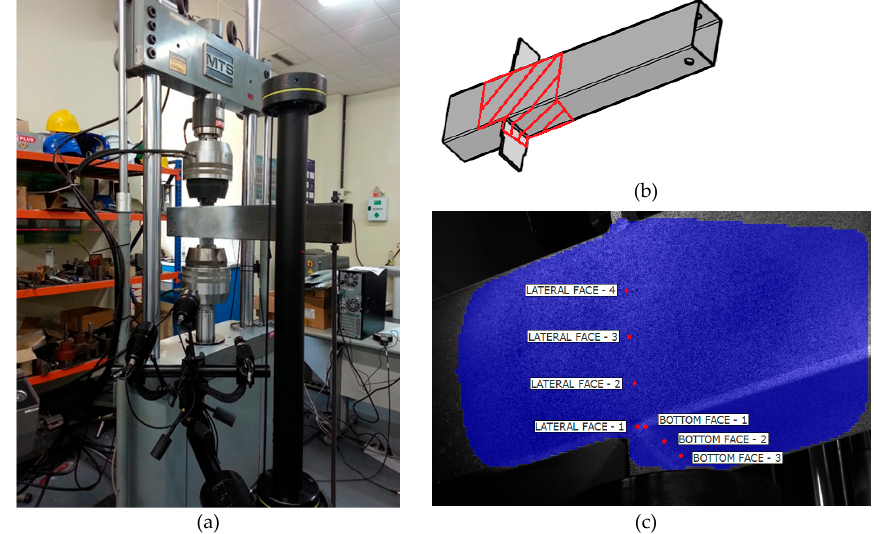
Figure 5. Compression test conducted with the support of Aramis 5M DIC system. ( a ) General set-up. ( b ) Area of interest. ( c ) Reference points.